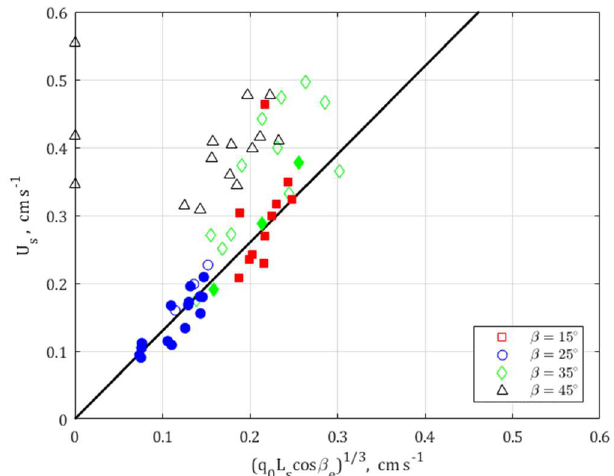
Figure 6. Local mean upslope velocity, U s , at the flow separation point. The filled in markers represent data with separation along the slope, L s / L 0 < 1, and empty markers represent cases with separation at the apex. The solid line is a linear fit of Equation (5) for the cases with separation before the apex where the proportionality constant γ = U s / ( q 0 L s cos β e ) 1/3 = 1.3, using the effective slope angle.